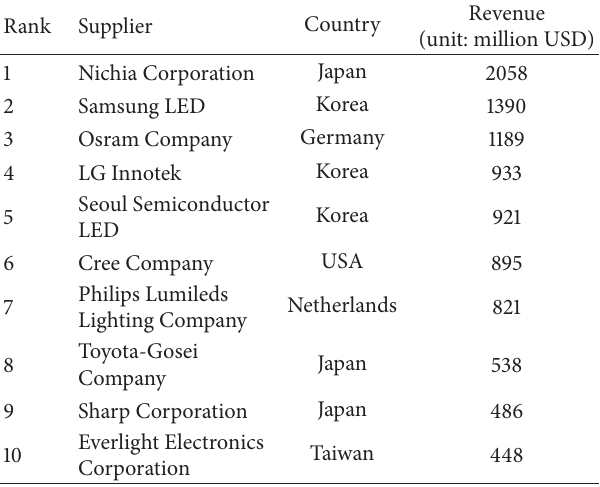
Table 2: Top 10 global LED components suppliers in 2013.